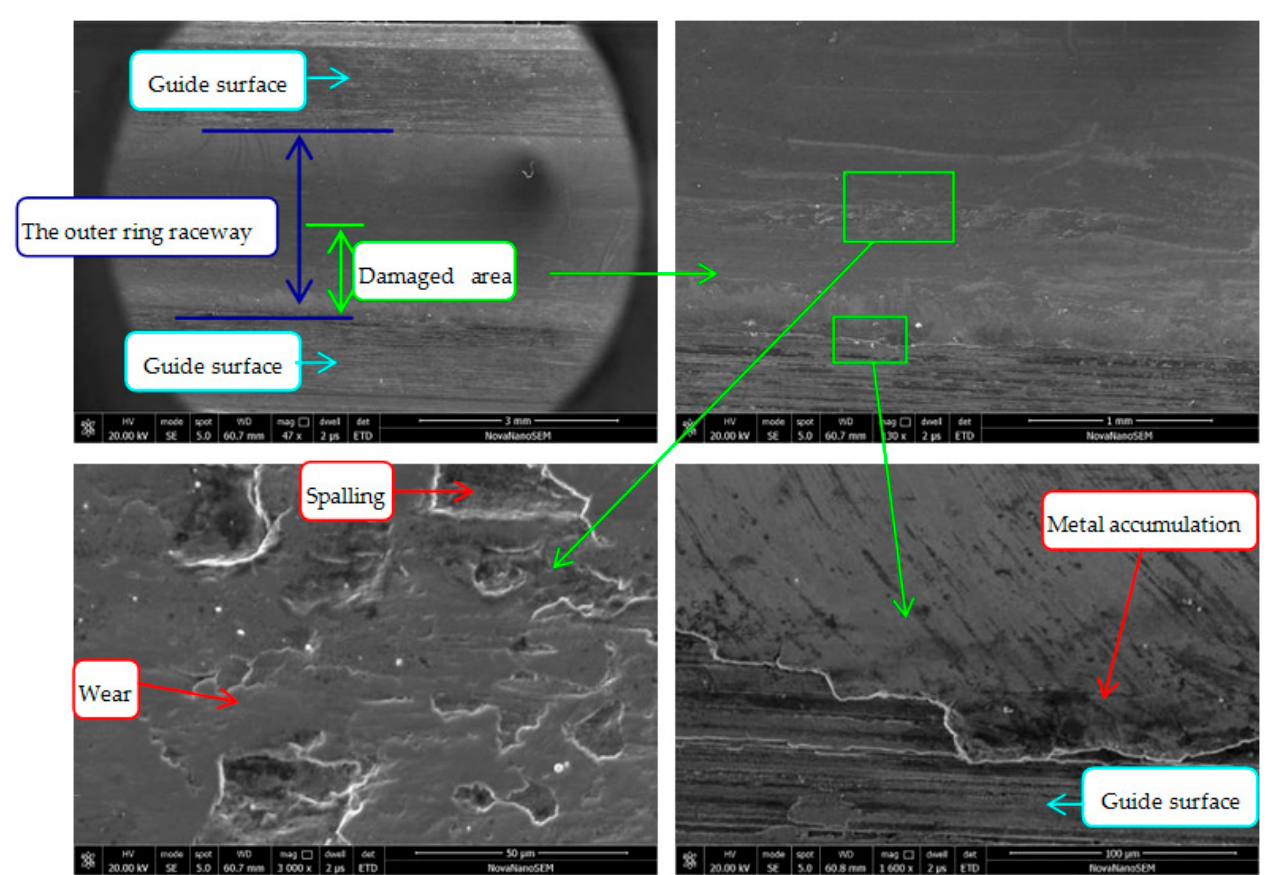
Figure 9. Damage morphology of the outer ring raceway.